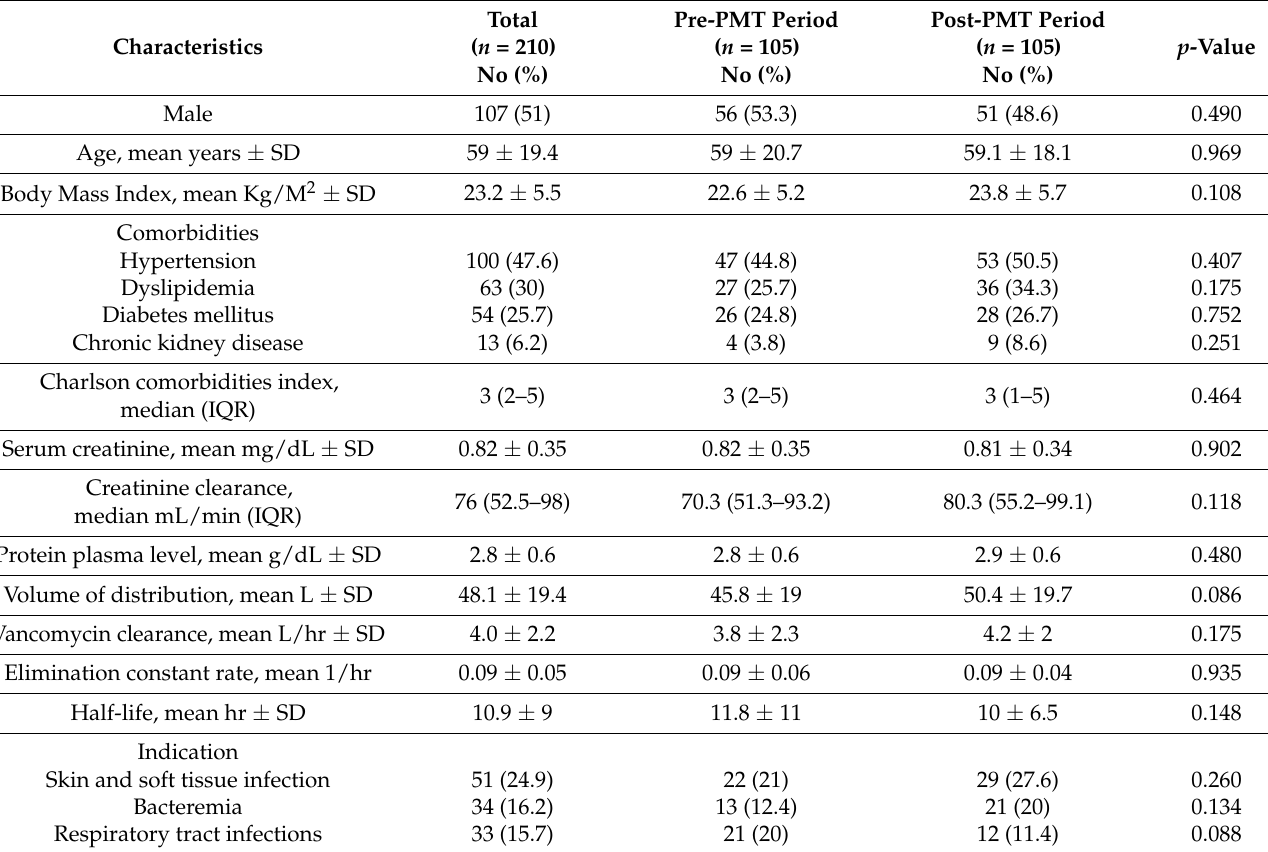
Table 1. Baseline characteristics.